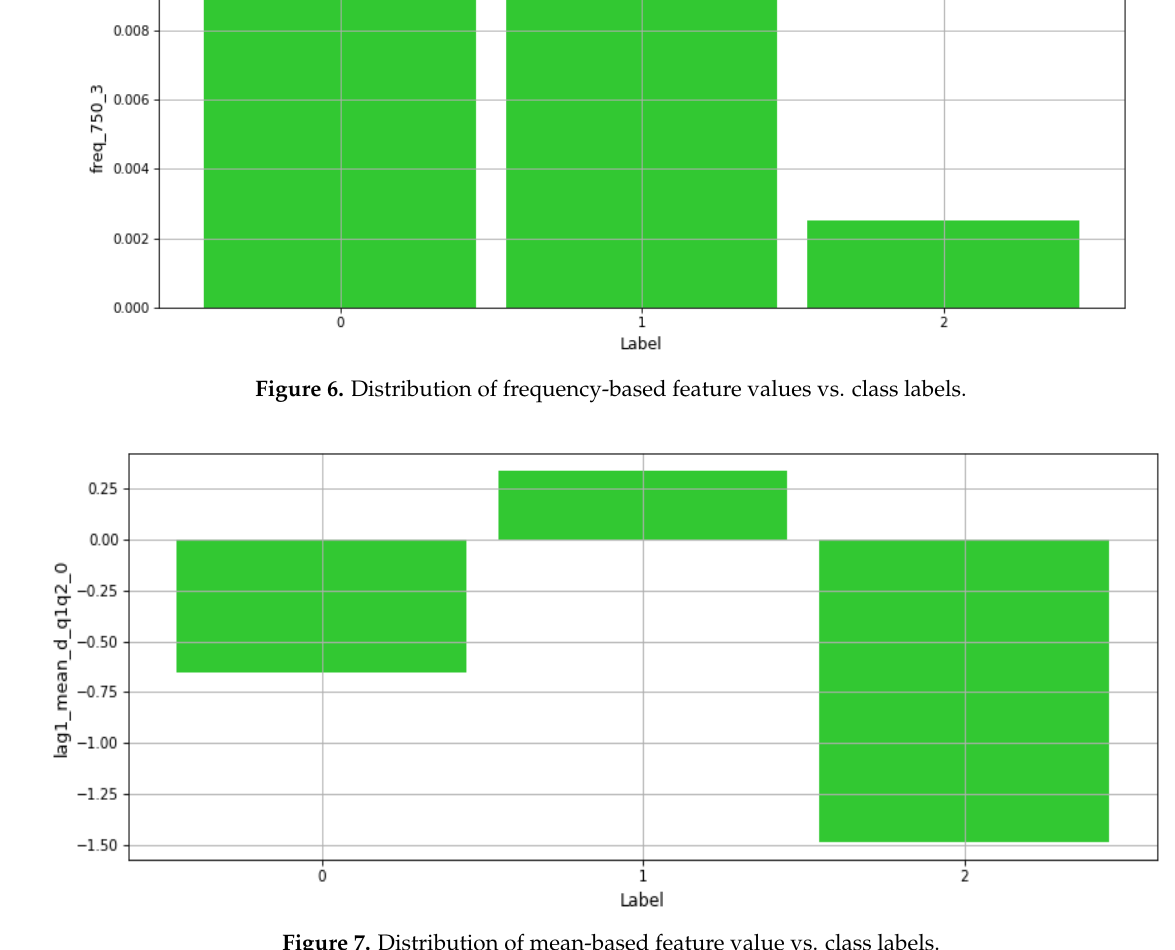
Figure 7. Distribution of mean-based feature value vs. class labels. Table 2. Forecast accuracy for Mental State